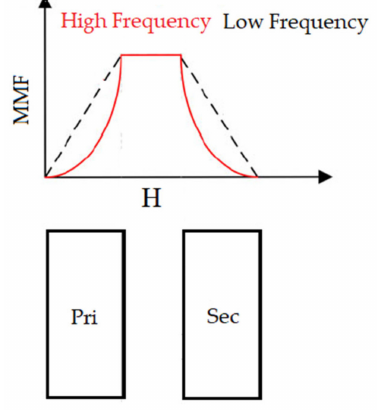
Figure 12. MMF variation due to high